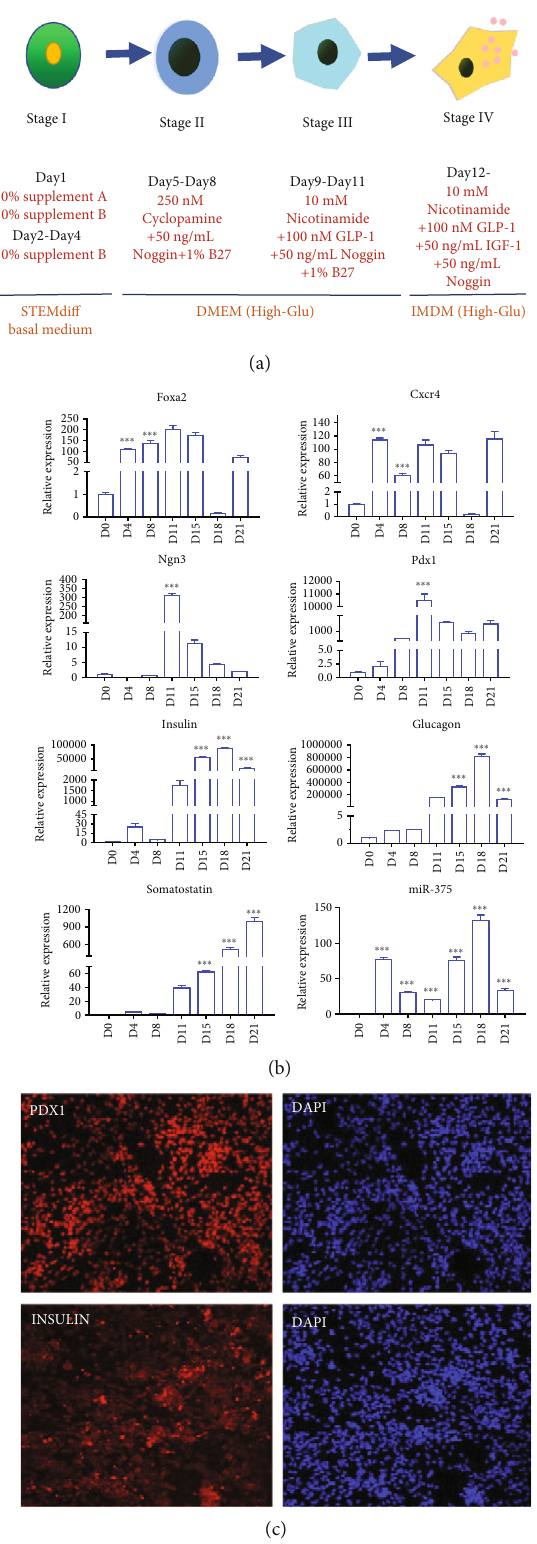
Figure 1: A four-stage protocol for di ff erentiation of human embryonic stem cells to insulin-producing cells. (a) Flowchart of the cell di ff erentiation process. Di ff erentiation is divided into four stages: de fi nitive endoderm (stage I), gastrulation (stage II), endocrine precursor (stage III), and pancreatic endocrine cell (stage IV). (b) The expression of marker genes at each stage of the di ff erentiation process. ∗∗∗ indicates P < 0 : 001 , ∗∗ indicates P < 0 : 01 , and ∗ indicates P < 0 : 05 . (c) Immuno fl uorescence detection of PDX-1 (samples collected on D13) and INSULIN (samples collected on D21). Scale bar =100 μ